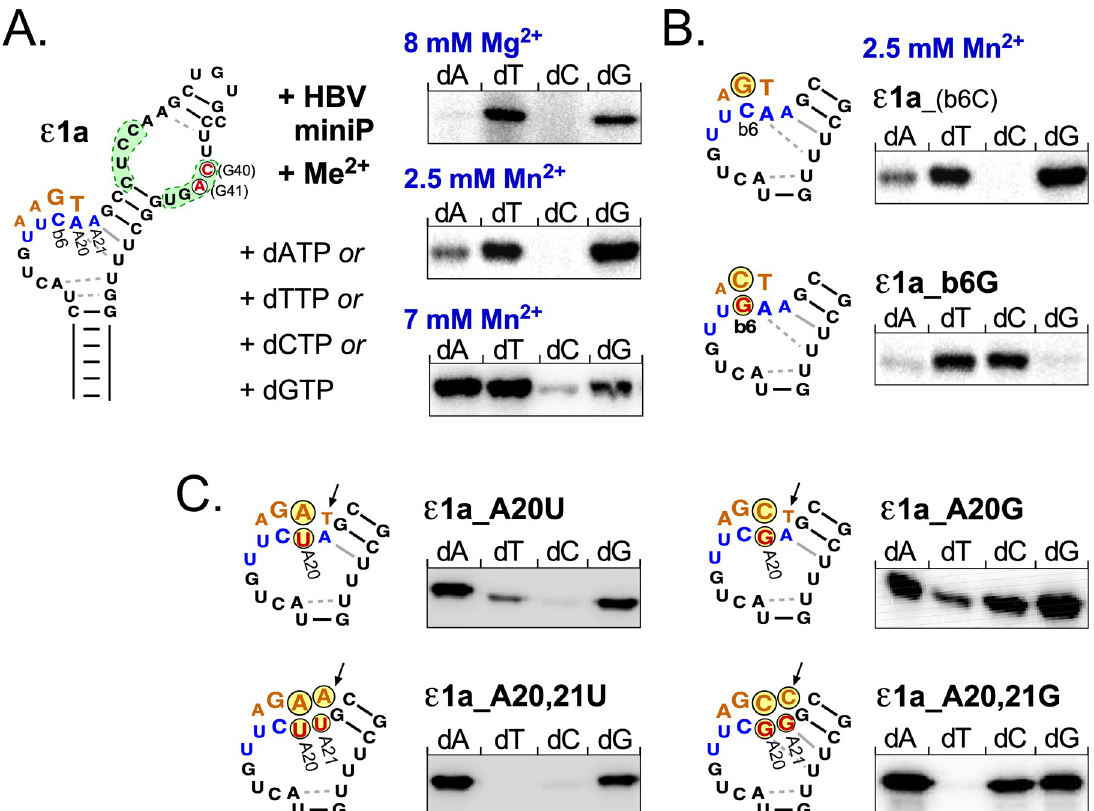
Fig 6. ε 1a RNA directs site-specific replication initiation in vitro. (A) Impact of bivalent metal ions on dNTP utilization. In vitro transcribed ε 1a RNA was subjected to priming reactions with renatured HBV miniP in the presence of the indicated Me 2+ concentrations and one each of the four natural dNTPs. The presumed template region around classical bulge position 6 (b6) and A20 (not paired according to SHAPE) and A21 plus the templated DNA nt are indicated in blue and red lettering in the structure model ( left) . Mg 2+ concentrations � 2.5 mM yielded very weak signals; at 8 mM Mg 2+ dTTP and dGTP produced clearly detectable signals ( top ). However. signal intensities were much enhanced by Mn 2+ , at 2.5 mM revealing low level priming also with dATP but not dCTP ( middle ); at 7 mM Mn 2+ dATP priming was much enhanced, dGTP priming somewhat reduced, and dCTP priming gave a well detectable band ( bottom ). Hence subsequent assays were routinely performed at 2.5mM Mn 2+ . (B) Bulge position 6 directs dGTP utilization. The C > G mutation at b6 ( ε 1a_b6G) switched dNTP preference from dGTP to dCTP but had little impact on dTTP and dATP priming. The autoradiogram for wildtype ε 1a (termed here ε 1a_(b6C) to emphasize the nt at b6) is the same as in the middle panel of A. (C) Bulge- following nucleotides A20, and to some extent A21, can direct dTTP utilization. Efficient dTTP utilization in all assays suggested A20 and possibly A21 as templates. Mutation A20U reduced dTTP priming and enhanced dATP priming ( top left ). Double mutation A20,21U virtually abolished dTTP priming ( bottom left ). Mutations A20G (top right ) and A20,21G ( bottom right ) gave analogous results regarding dTTP priming but additionally enabled dCTP utilization.